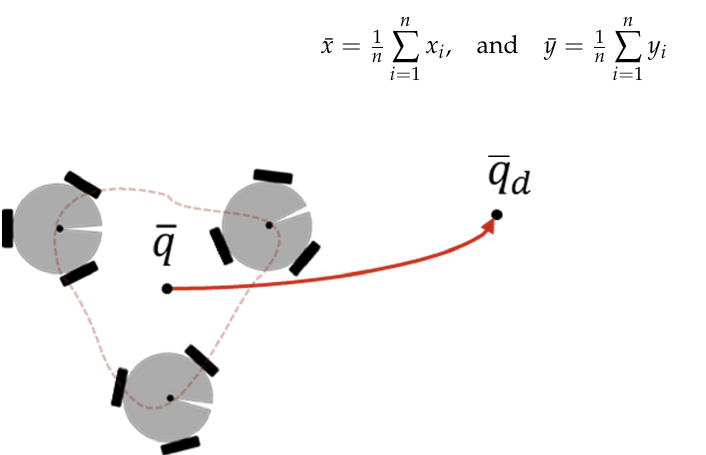
Figure 5. Cooperative regulation